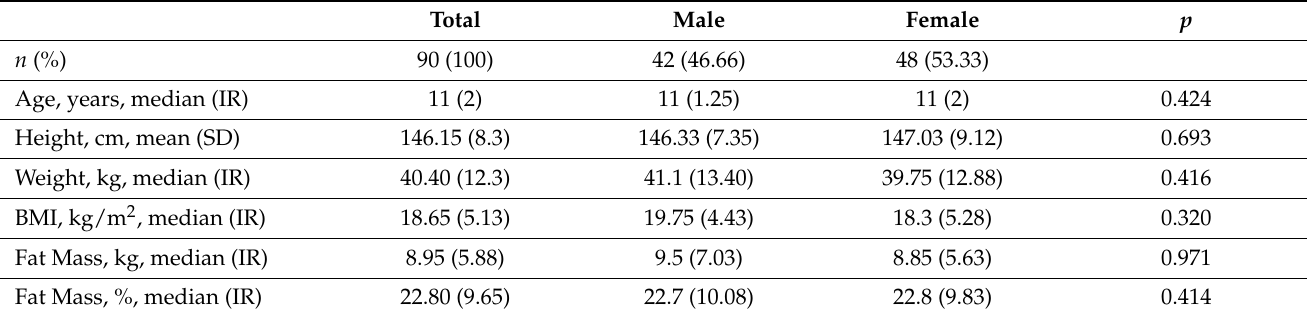
Table 1. Participants’ characteristics.